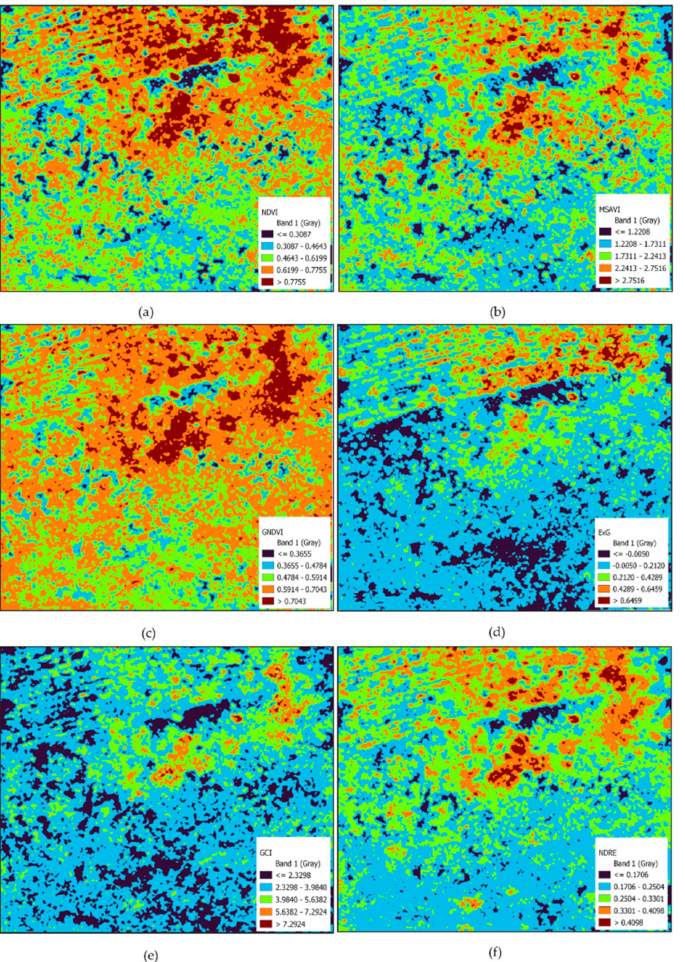
Figure 5. Vegetation Indices (EPSG:4326—WGS 84) ( a ) NDVI; ( b ) MASVI; ( c ) GNDVI; ( d ) ExG; ( e ) GCI; ( f )